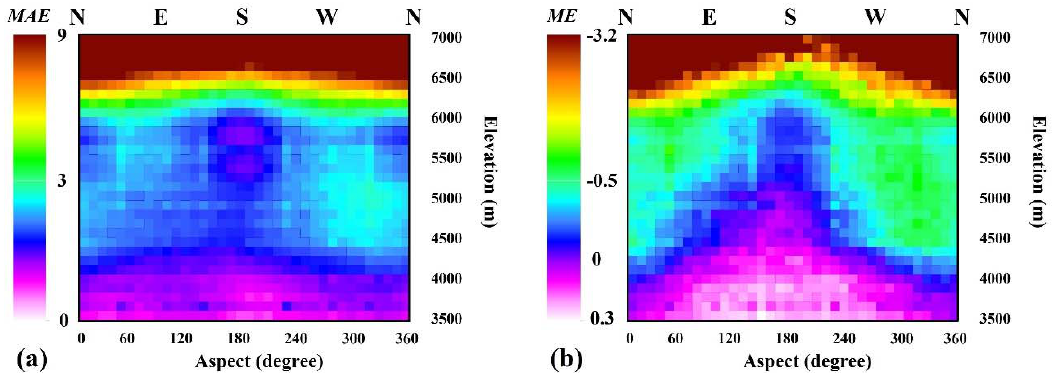
Figure 18. Relationship between accuracy and topographical factors (elevation and aspect): ( a ) mean absolute error ( MAE ) and ( b ) mean error ( ME ). A positive ME value indicates that the model overestimated the true value, whereas a negative value represents an underestimation.